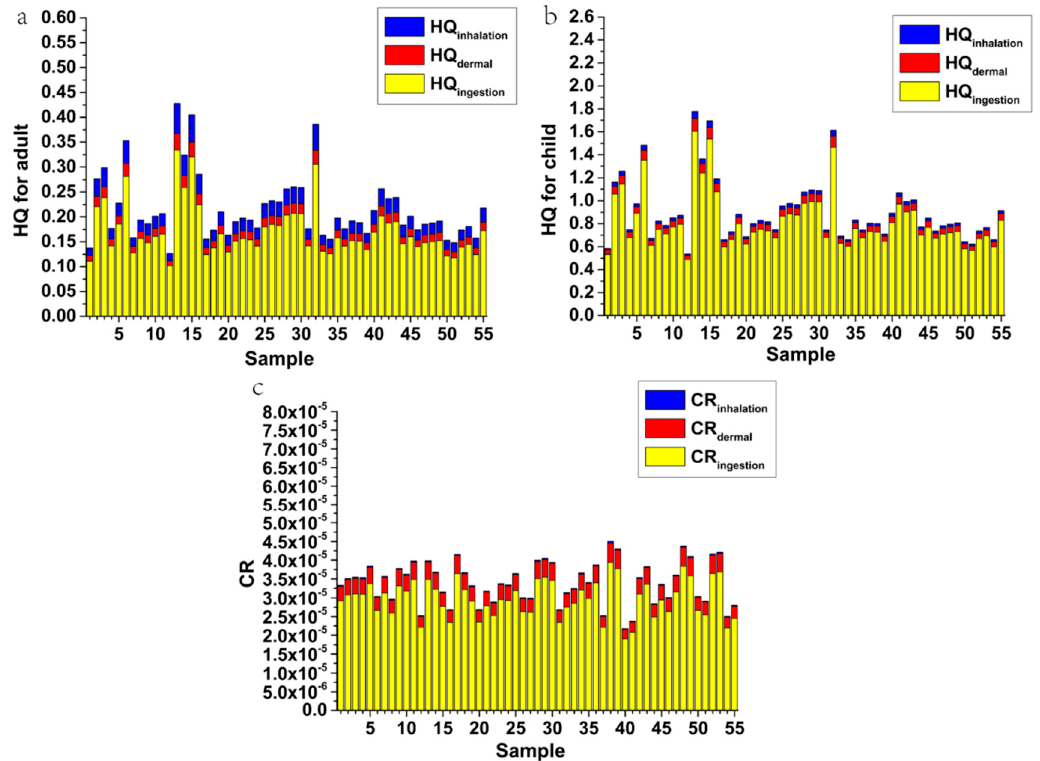
Figure 4. Non-carcinogenic (( a ): adult and ( b ): child) and carcinogenic risks (CRs) ( c ) of PTEs in soil.